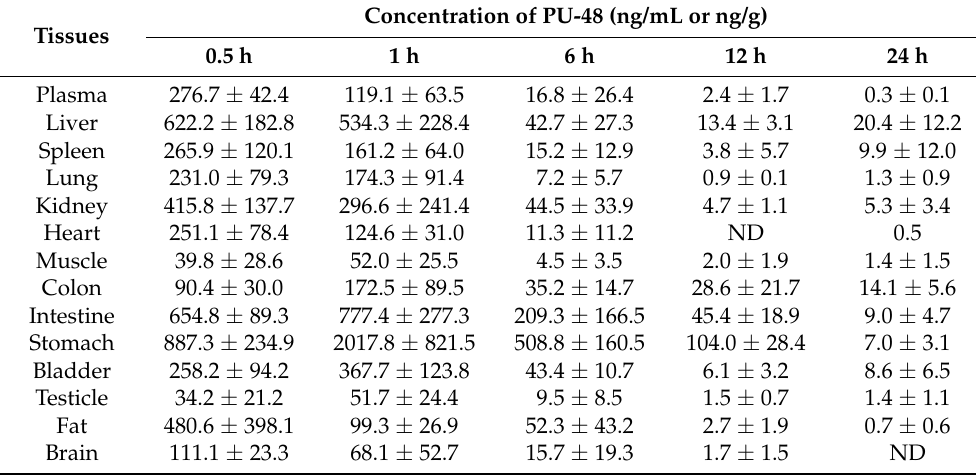
Table 2. Tissue distribution-time course after single oral administration of methyl 3-amino-6- methoxythieno [2,3-b] quinolone-2-carboxylate (PU-48) SNEDDS (12 mg/kg) in rats ( n = 6, mean ± SD).